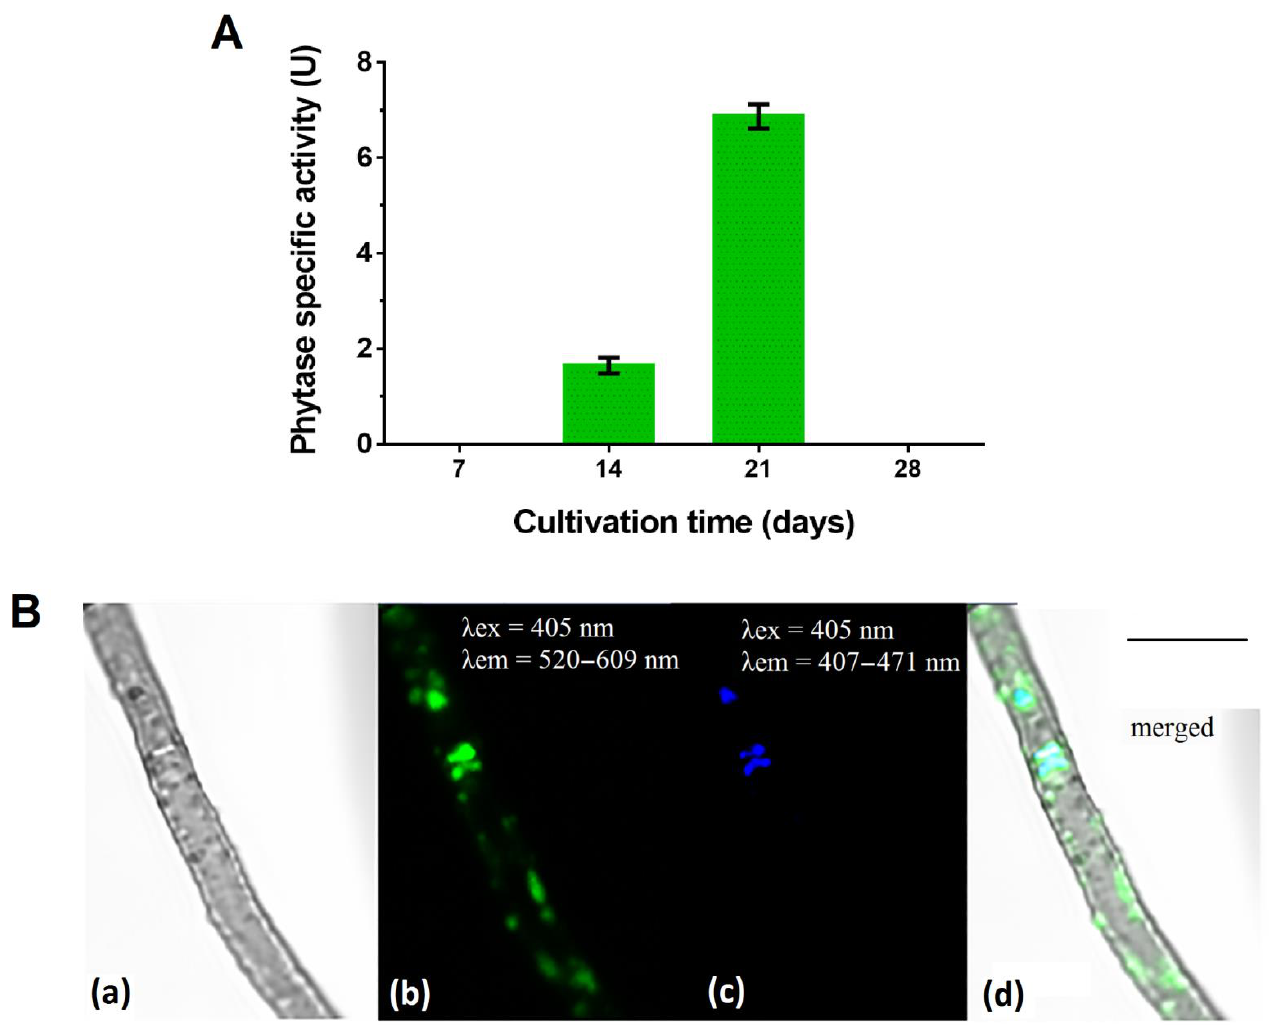
Figure 4. P. fortinii DSE2 isolate’s phytase activity and ability to accumulate phosphorus in mycelium: ( A ) P. fortinii DSE2 isolate’s phytase activity during cultivation on liquid potato-dextrose broth. One unit of phytase-specific activity (1 U) is counted as the amount of phosphorus (μg) released in 1 min per 1 μg of protein. Different letters indicate statistically significant differences between different days of cultivation, p < 0.05; ( B ) polyphosphate’s localization in P. fortinii DSE2-isolate hyphae stained with DAPI: ( a ) transmitted light image; ( b ) fluorescence of DAPI–polyP complexes, λ ex = 405 nm, λ em = 520–609 nm; ( c ) fluorescence of nuclei, λ ex = 405 nm, λ em = 407–471 nm; ( d ) merged image. Bar = 5 μ m.